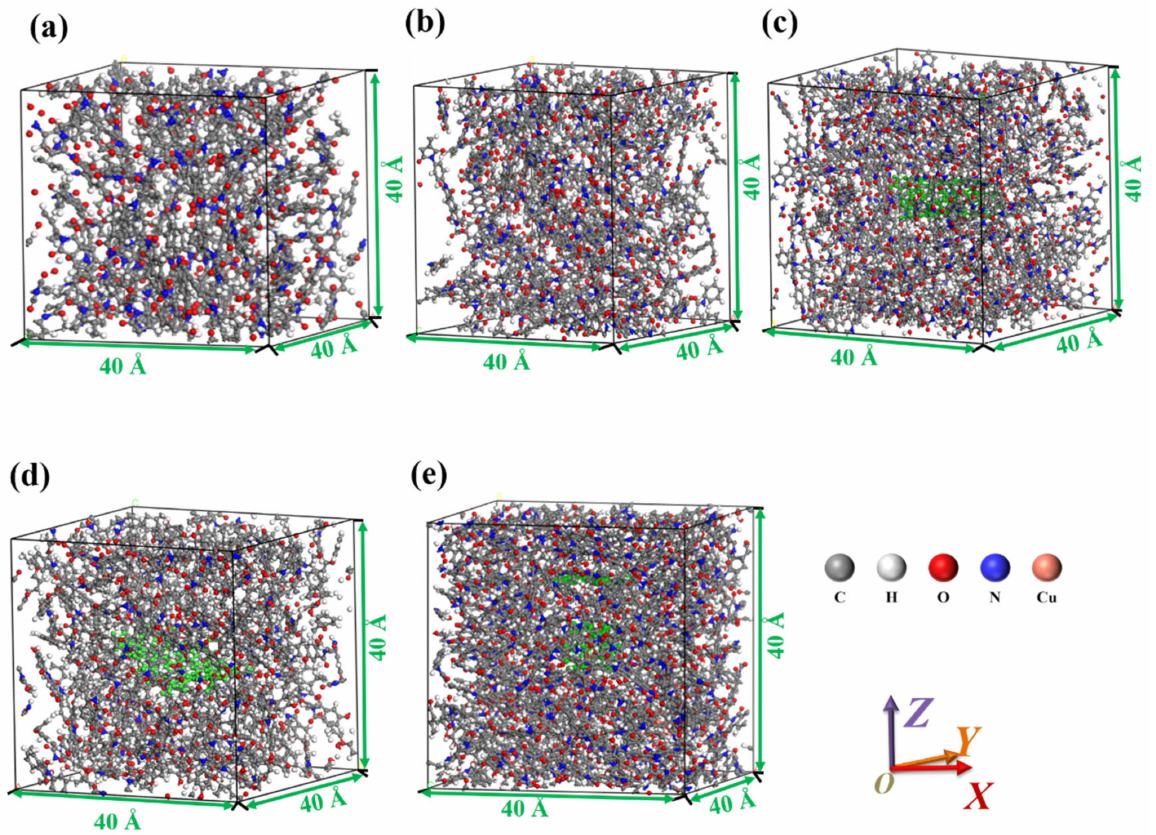
Figure 2. Molecular models of the ( a ) PI, ( b ) Cu/PI, ( c ) CNT/PI, ( d ) GNS/PI, and ( e ) composite